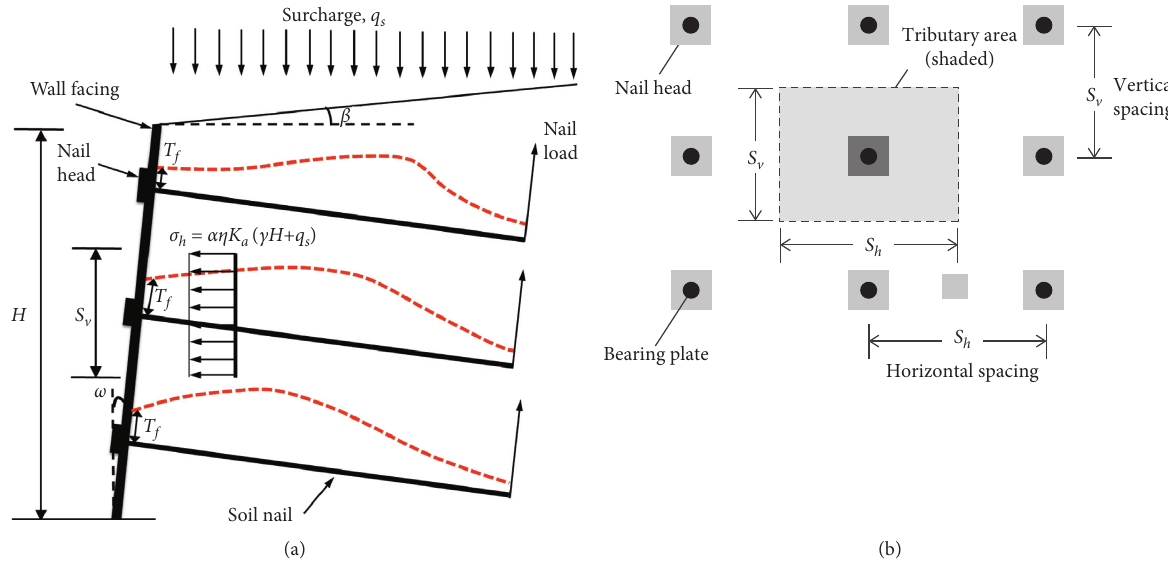
Figure 1: Facing of a typical soil nail wall: (a) side view; (b) front